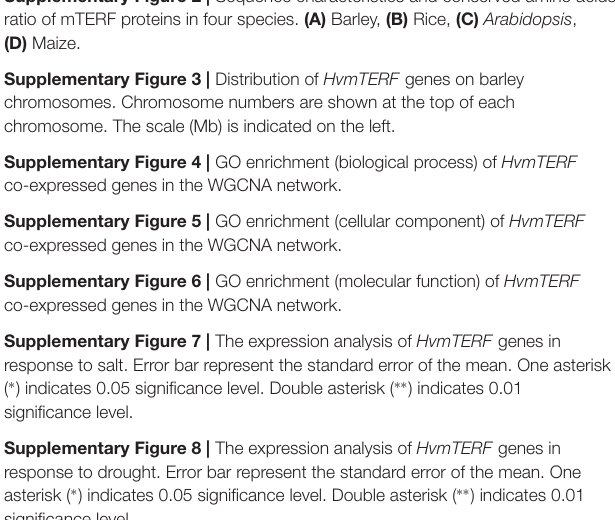
Supplementary Table 11 | GO enrichment of HvmTERF co-expressed genes.